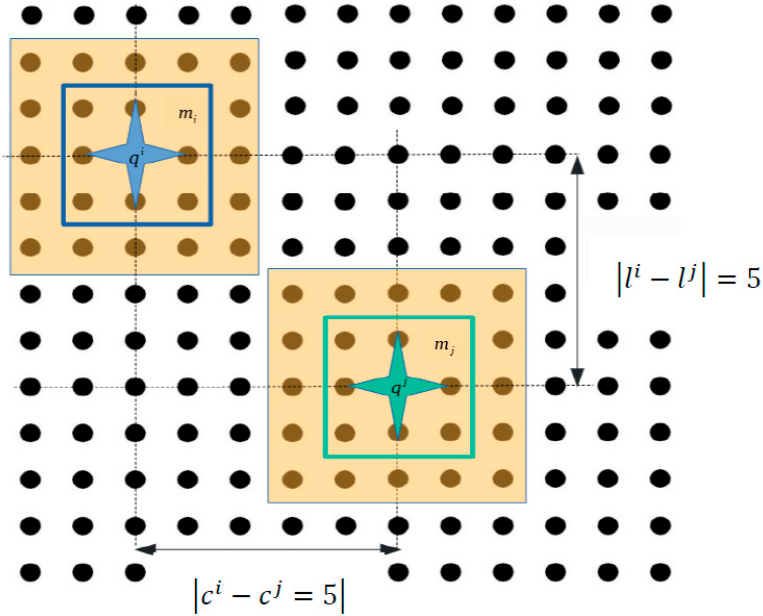
Figure 17. Collision due to wrong simultaneous activations.